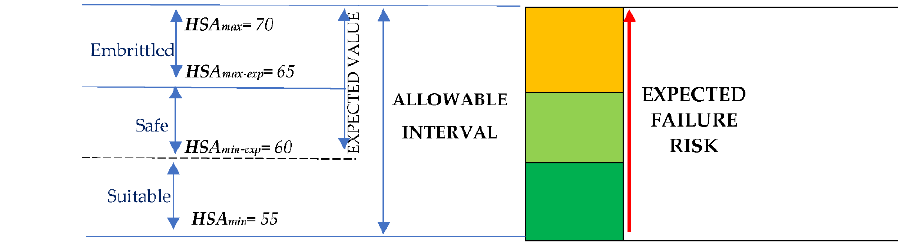
Figure 8. Hardness intervals and their correspondence to the risk of failure (loss of integrity due to aging).